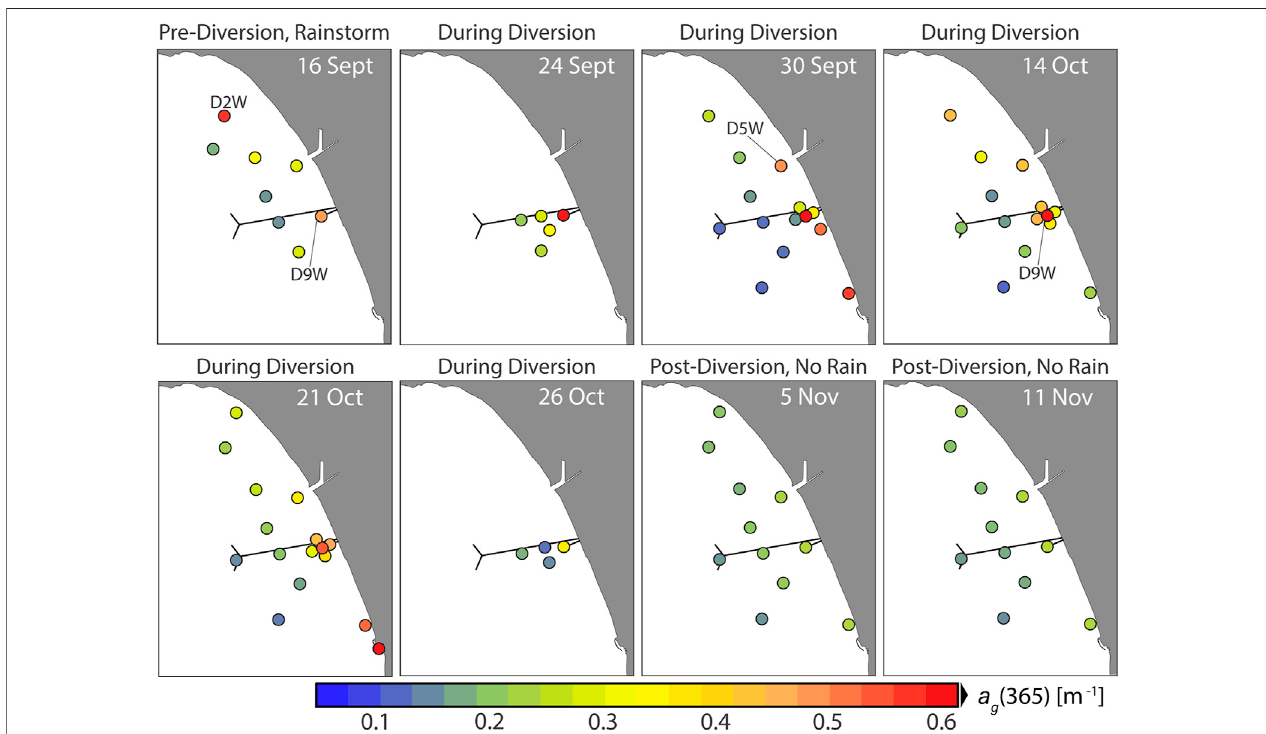
FIGURE 2 | Map of in-situ a g (365) measured during the fi eld campaign in the fall 2015. Pre-diversion samples were measured on September 16 after a heavy precipitationeventonSeptember15( > 6 cmofrain)andexhibitedhigherCDOMcontentatthenorthendofthebay.Duringthewastewaterdiversion,thehighest a g (365) were observed near the 1-mile outfall. After the end of the wastewater diversion, there was little precipitation, and a g (365) was low at all sampling stations across Santa Monica Bay.